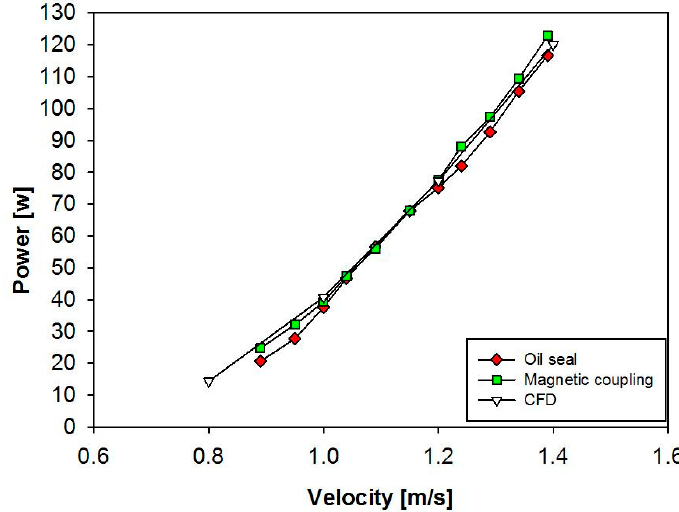
Figure 12. The power output against water velocity. Comparison between the oil seal, magnetic coupling experimental results and Computational Fluid Dynamics (CFD) results.